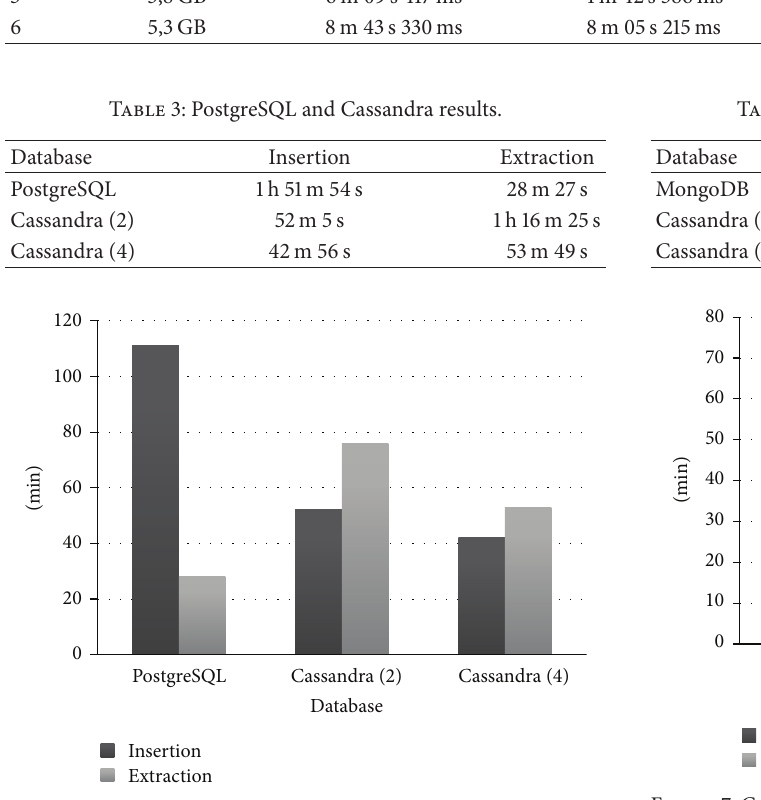
Figure 6: Comparison between Cassandra and PostgreSQL.